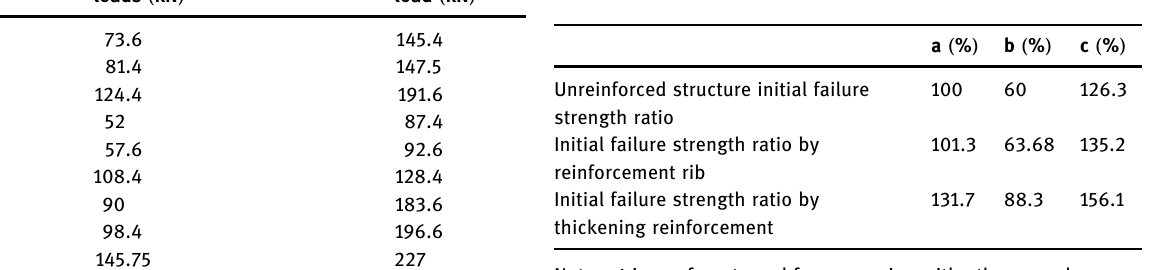
Table 5: Comparison of relative initial failure